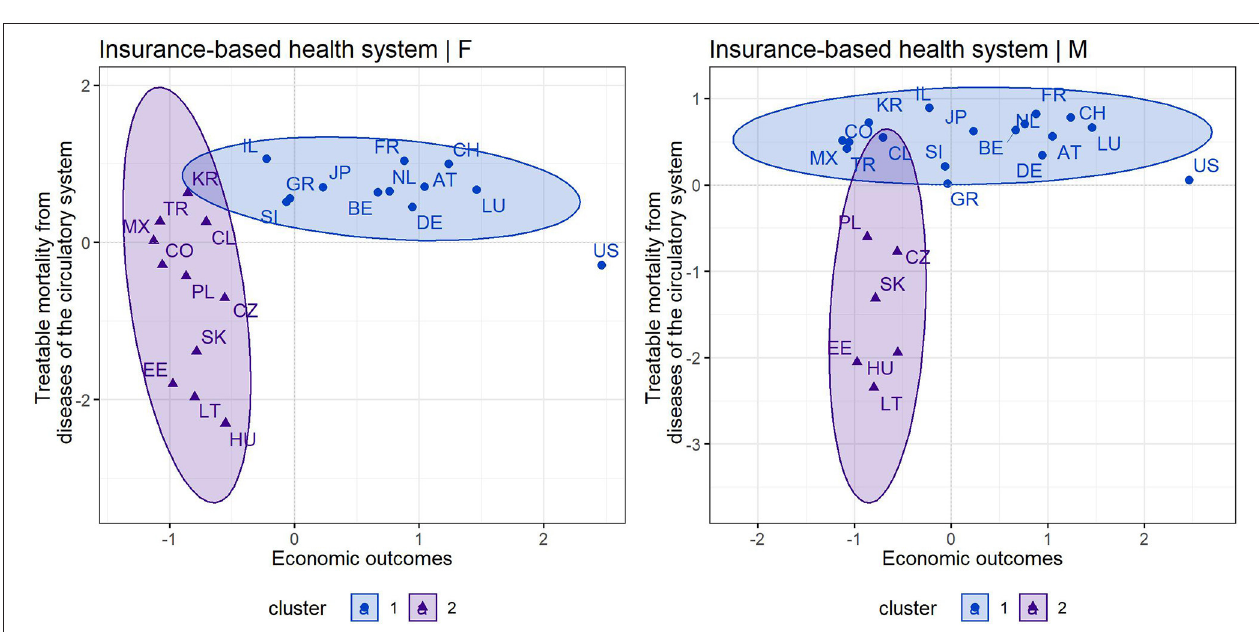
model with random effects. Conversely, a one-way model with fixed effects was preferred in the case of the female population of countries with a tax-based health system, as the results of the Hausman test showed a p < 0.05. In terms of the associations between treatable mortality due to endocrine, nutritional